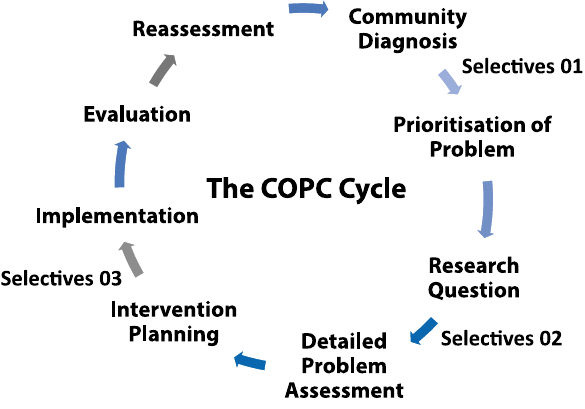
Figure 2: Community Oriented Primary Care cycle and its relationship to the Selectives Programme. Source: Adapted from Kark and Kark.